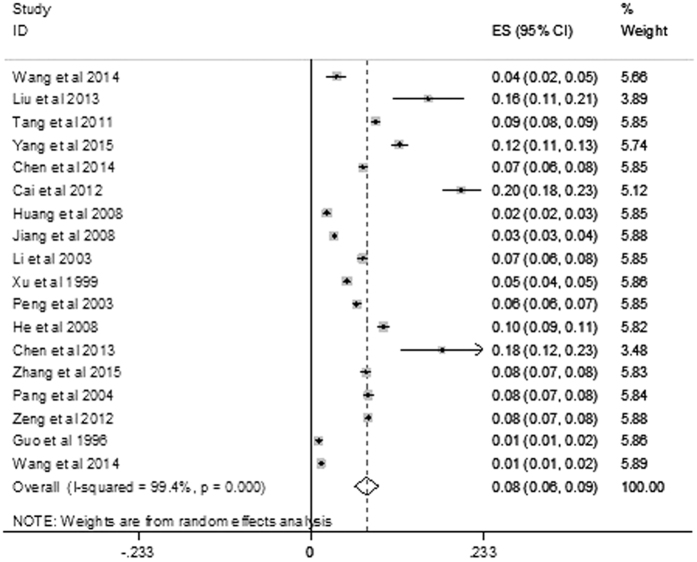
Forest plot for the overall estimate of the prevalence of kidney stones.